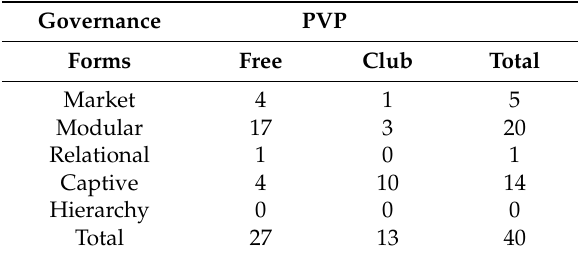
Table 3. Results of the quick assessment of the governance forms in the Agro Pontino Kiwifruit value chains. Governance PVP Forms Free Club Total Market 4 5